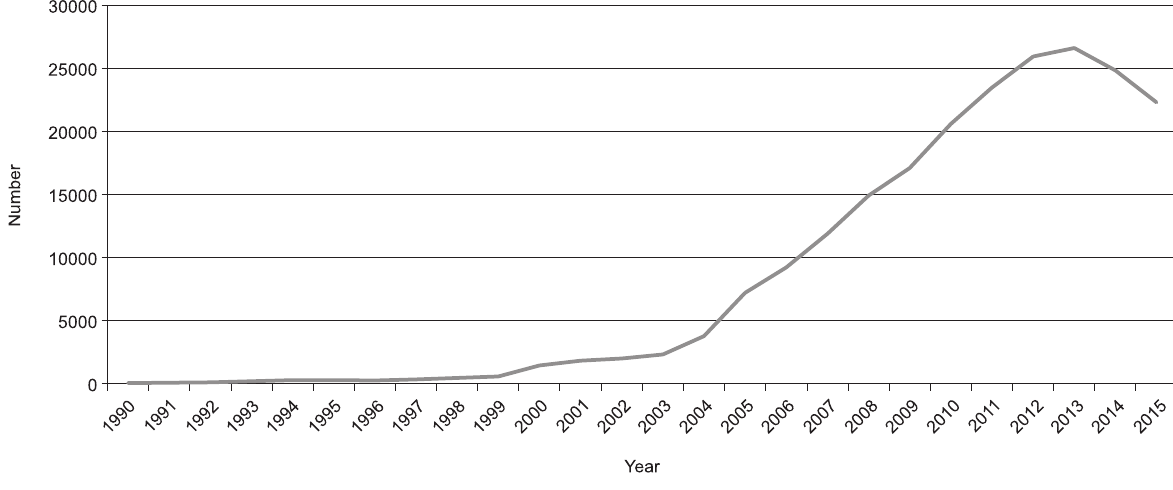
Fig. 1. Number of organic farms in Poland in 1990–2015. Source: own calculations based on the IJhArS report.